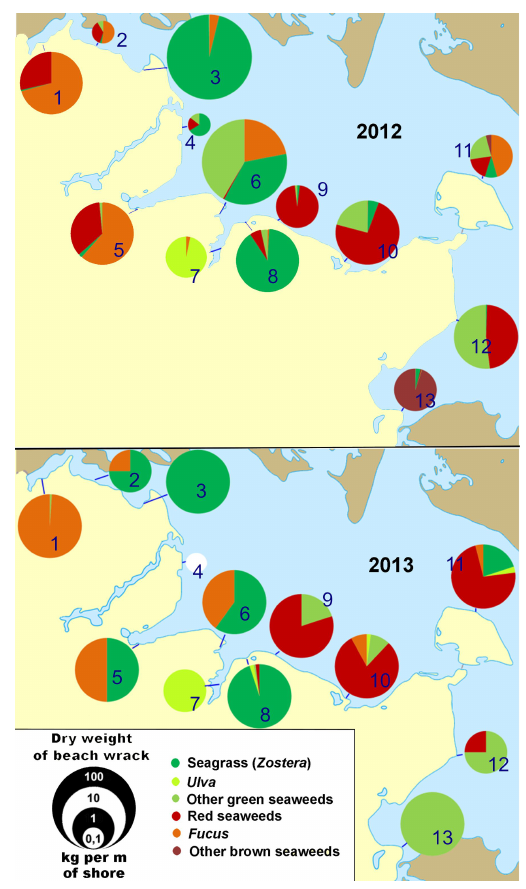
Fig. 2 . Quantity and composition of beach wrack at 13 sites along the Baltic Sea shore of Schleswig-Holstein in the two periods 12.8. to 16.8.2012 (top) and 14.8. to 24.8.2013 (bottom). Blue numbers correspond with site numbers given in Table 1. No beach wrack was detected in 2013 in site 4 (Schönhagen, see also tables S2A and